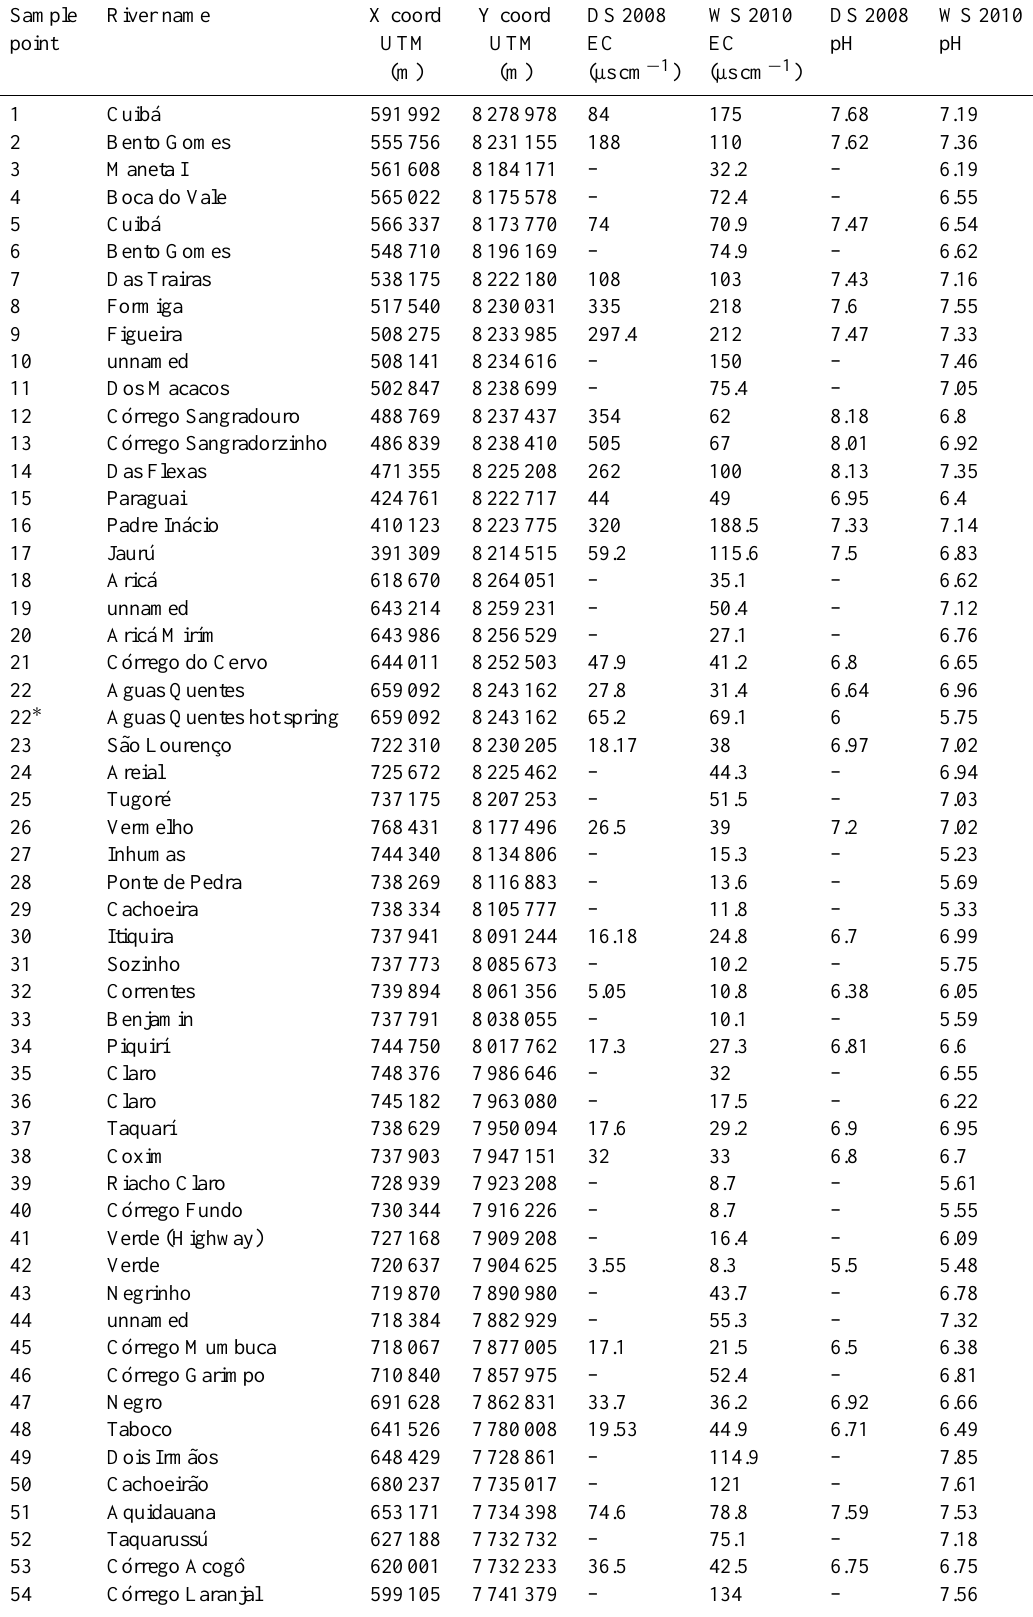
Table 1. Field measurements and coordinates of DS and WS samplings.